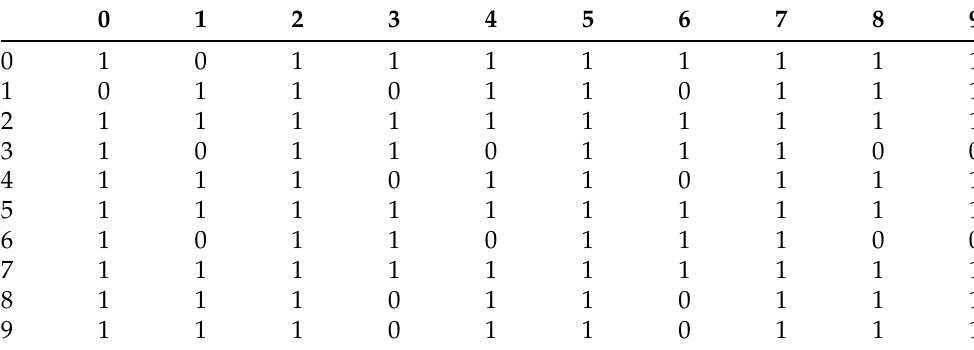
Table 8. The matrix that was used by the LP model to generate the gateway activation.